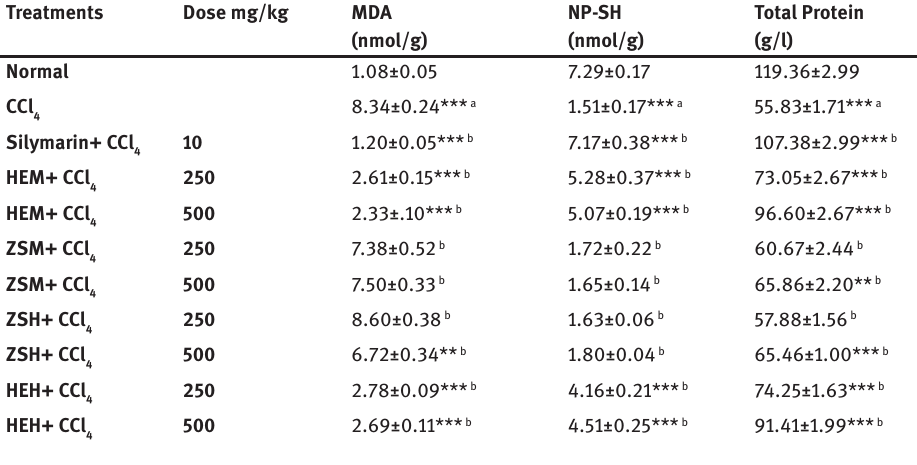
Table 3: Effect of Extracts on MDA , NP-SH and Total Protein in liver tissue. Treatments